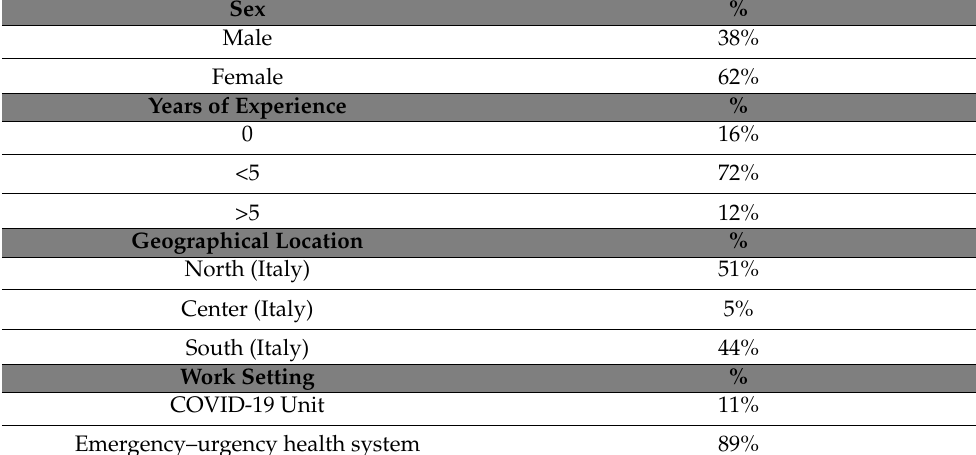
Table 1. Sociodemographic